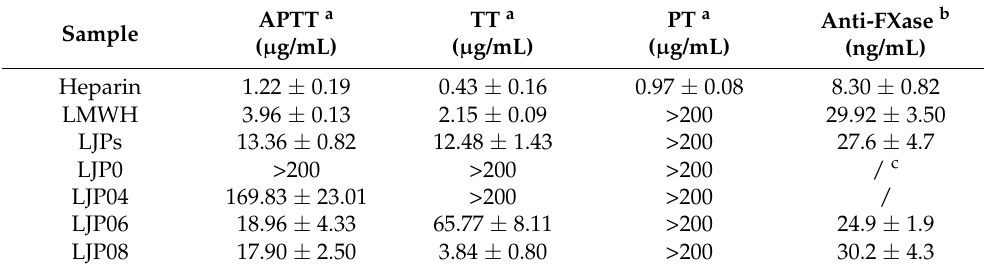
Table 2. Anticoagulant activity of LJPs LJP0, LJP04, LJP06, and LJP08 ( n =